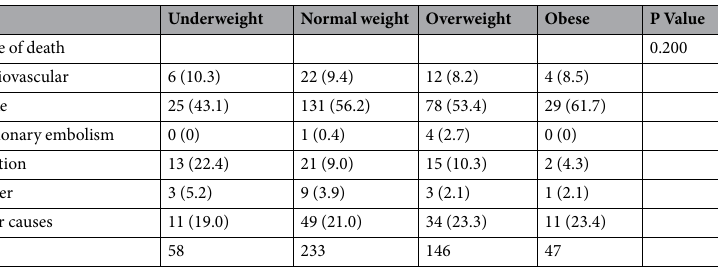
Table 4. Causes of death by body mass index subgroup. P value by Chi-square test. Numbers in parentheses indicate